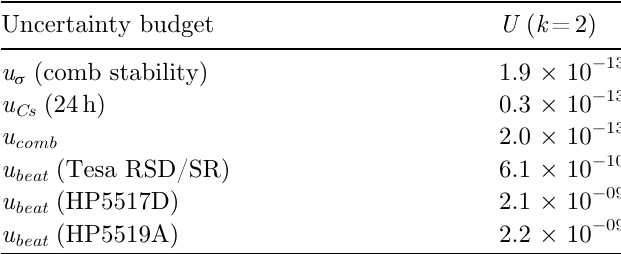
Table 2. The expanded uncertainty sources values involving in the measurement of frequency